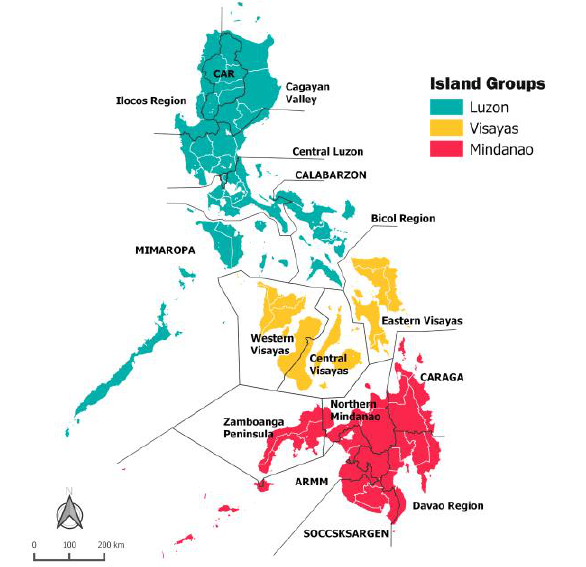
Figure 1. Island groups and regions in the Philippines.